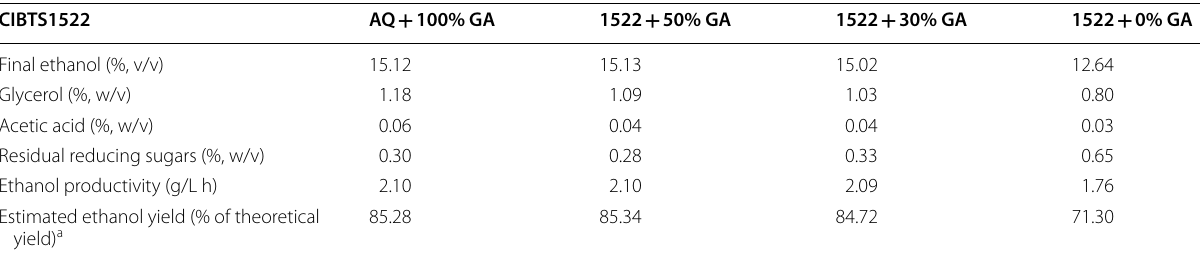
Table 3 Product formation by the CIBTS1522 strain after 72 h of fermentation in the corn starch liquefied slurry at small-